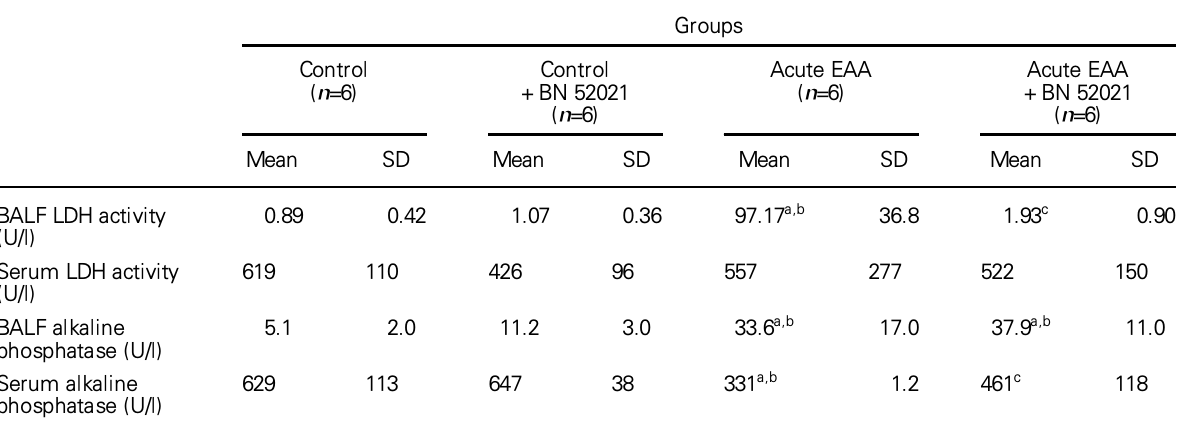
Table 2. LDH and alkaline phosphatase values